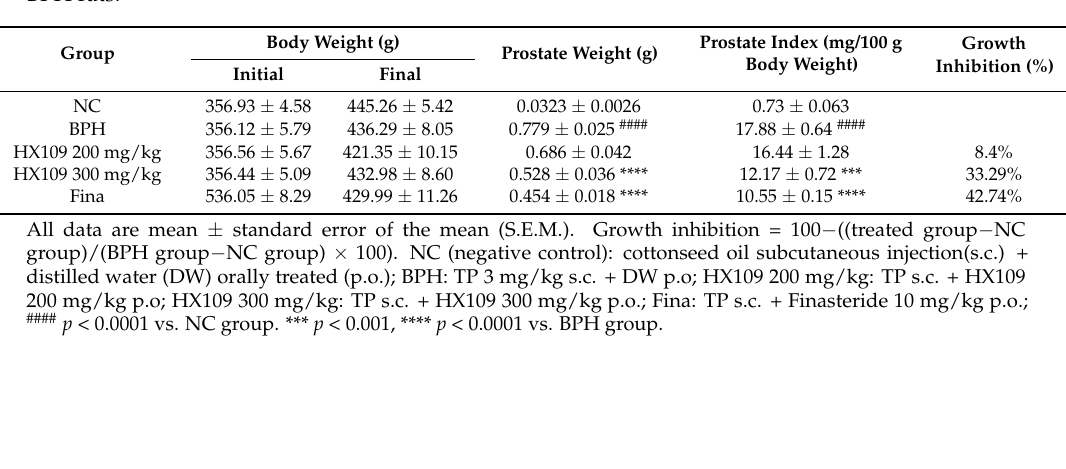
Table 1. Effects of HX109 on body weight and prostate weight in testosterone propionate (TP)-induced BPH rats.